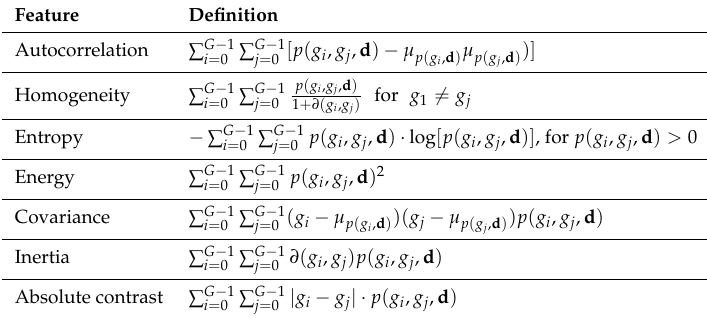
Table A1. Definition of the Haralick